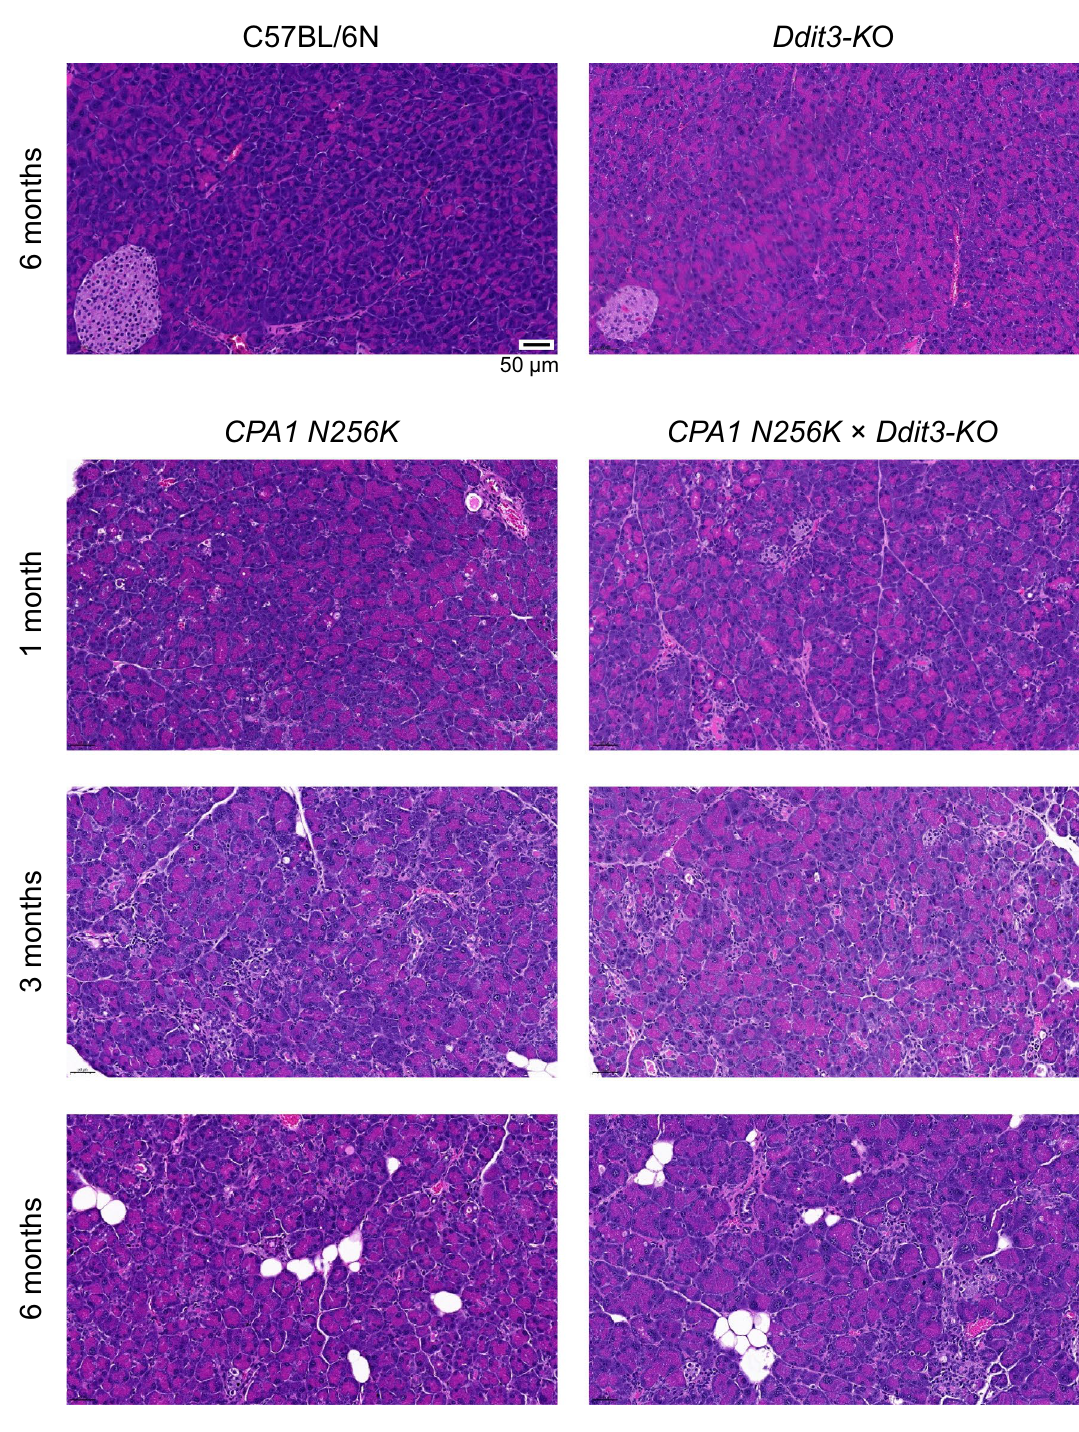
Figure 5. Histology of chronic pancreatitis in CPA1 N256K × Ddit3-KO mice. Representative hematoxylin– eosin stained pancreas sections are shown from C57BL/6N and Ddit3-KO mice at 6 months of age and from CPA1 N256K and CPA1 N256K × Ddit3-KO mice at 1, 3, and 6 months of age. The scale bar corresponds to 50